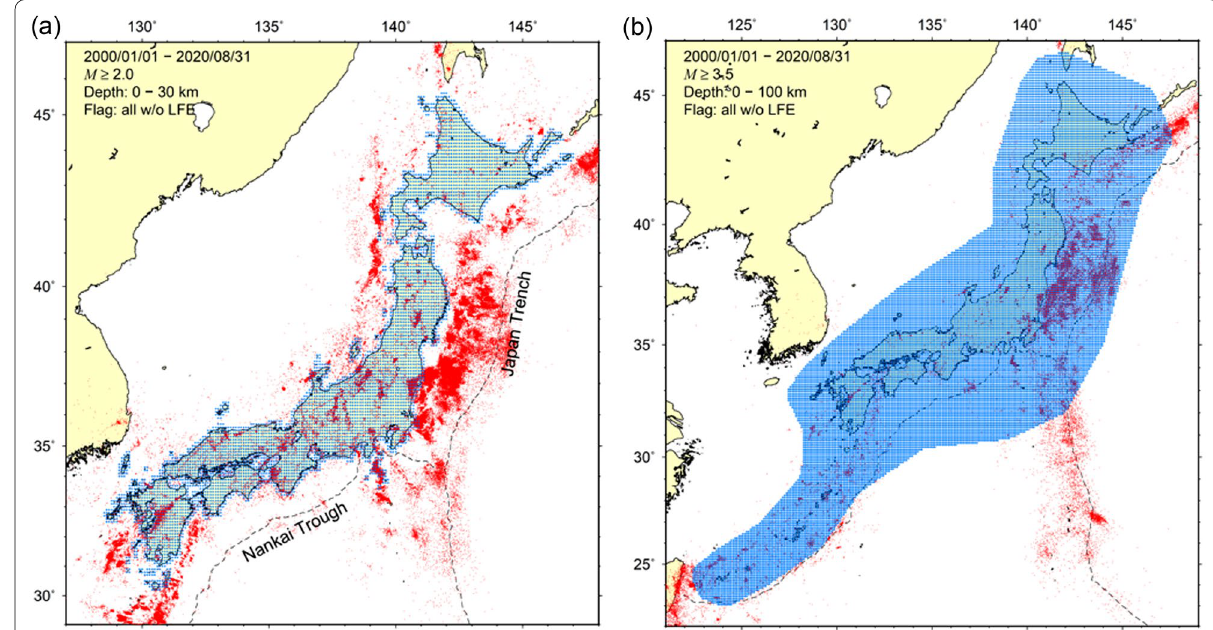
Fig. 1 The epicentral distribution and centers of the rectangular areas used in the analyses. Red dots show epicenters and blue crosses show the 0.2 ◦ ( 0.1 ◦ intervals in accordance with CSEP-Japan). For l 0.4 ◦ , the center of the rectangular area ( 0.2 ◦ intervals) was the center of each grid for l = = point where both the latitude and longitude were halved. a Land areas (area A); b the entire area in and around Japan (area